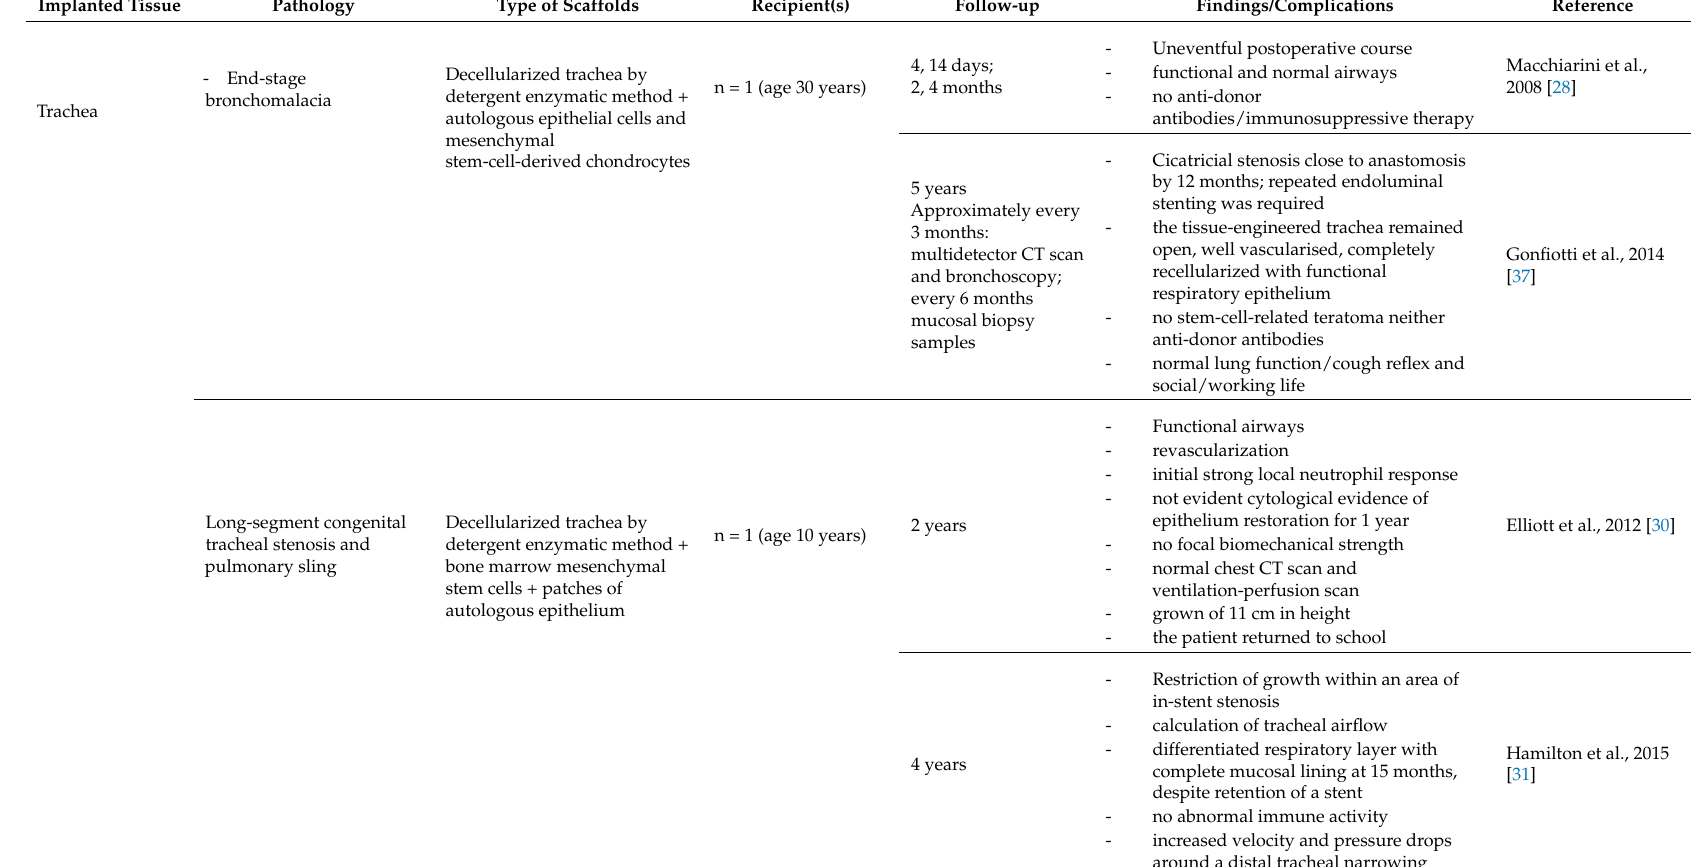
Table 1. Clinical trials. Human implantation of decellularized extracellular matrix (ECM)